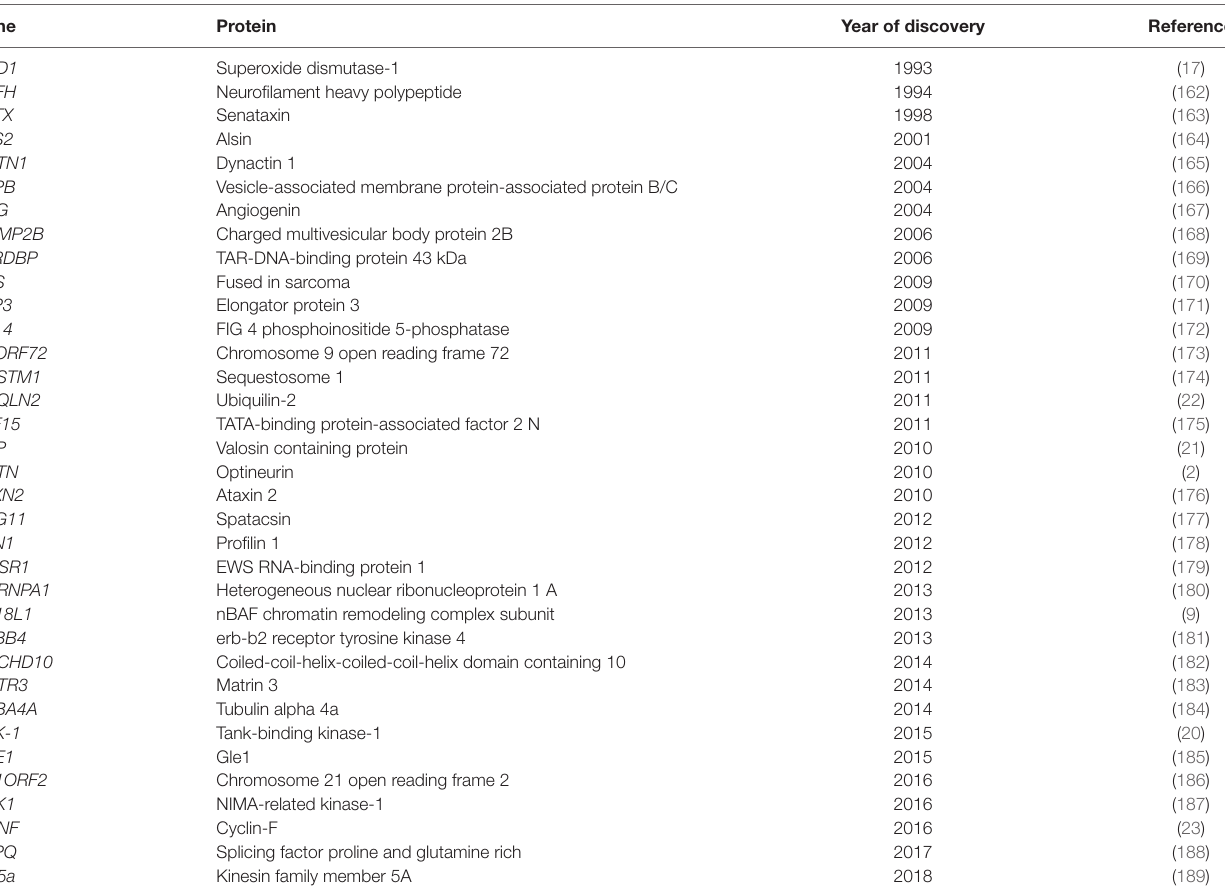
TAbLe 1 | Genes associated with familial ALS.